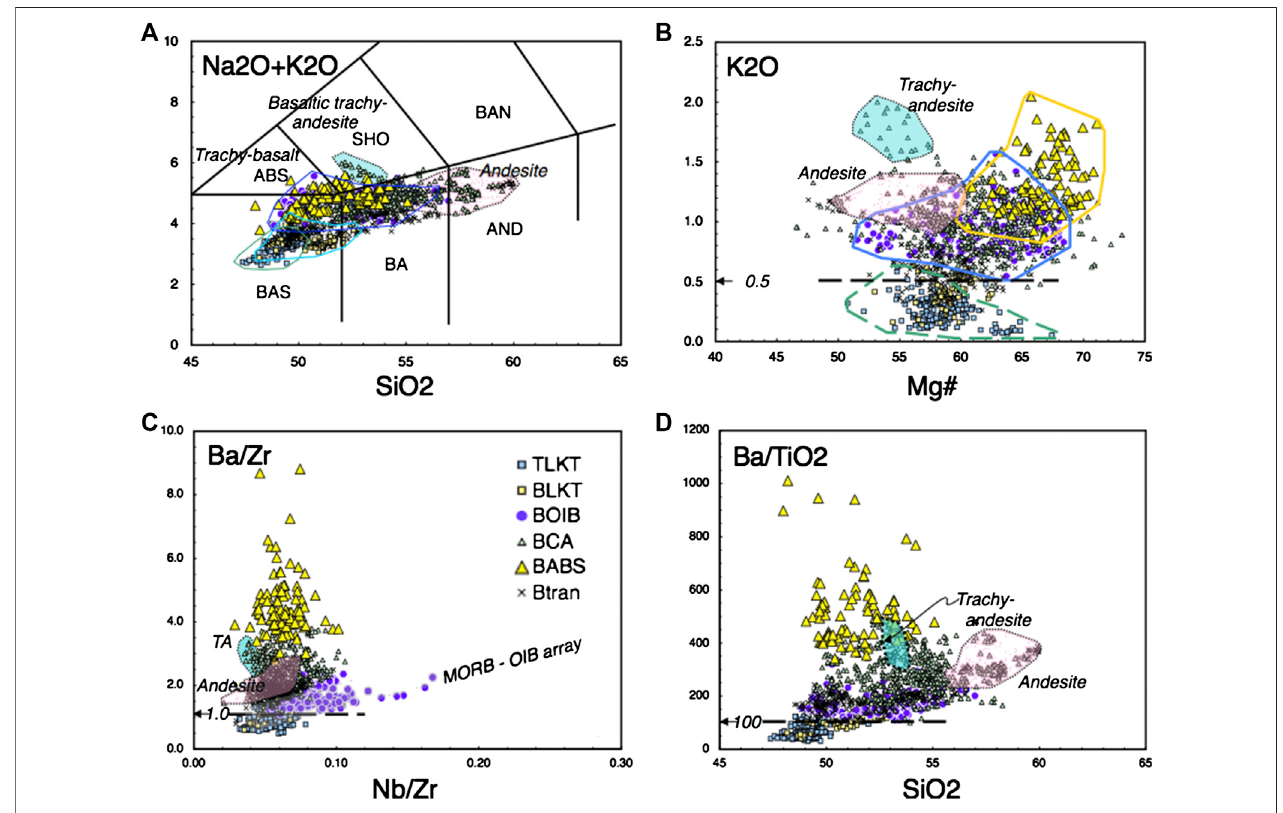
FIGURE6| Variation diagrams for lavas ofthe Boring Volcanic fi eld(BVF) arebased onXRF analyses of 1,271samples(Leeman et al.,2005,Leemanet al., 2019); these show range in (A) SiO 2 vs. total alkalis, (B) Mg# ( (cid:1) Mg/[Mg + Fe], molar ratio) vs. K 2 O, (C) Nb/Zr vs. Ba/Zr, and (D) SiO 2 vs. Ba/TiO 2 . Symbols denote assigned magma type based on these and other discriminant diagrams. Fields in (A) are labeled to indicate compositional space for basalt (BAS), basaltic andesite (BA), andesite (AND),absarokite(ABS,orTrachy-basalt),shoshonite(SHO,orBasaltictrachy-andesite),andbanakite(BAN)asreferredtointext.Symbolkey:agedifferencesare denoted by pre fi x “ T ” for Pliocene (3.0 – 3.6 Ma) or “ B ” for Quaternary ( < 2.6 Ma); magma types include “ low-K tholeiite ” (LKT), “ ocean island-like ” (OIB), and “ calcalkalic ” (CA) basalts, and “ absarokitic ” (ABS), “ andesitic ” (AND), and “ transitional ” (Tran; mixtures or otherwise ill-de fi ned) lavas. Dashed lines denote upper limit values for K 2 O, Ba/Zr, and Ba/TiO 2 used to distinguish the LKT